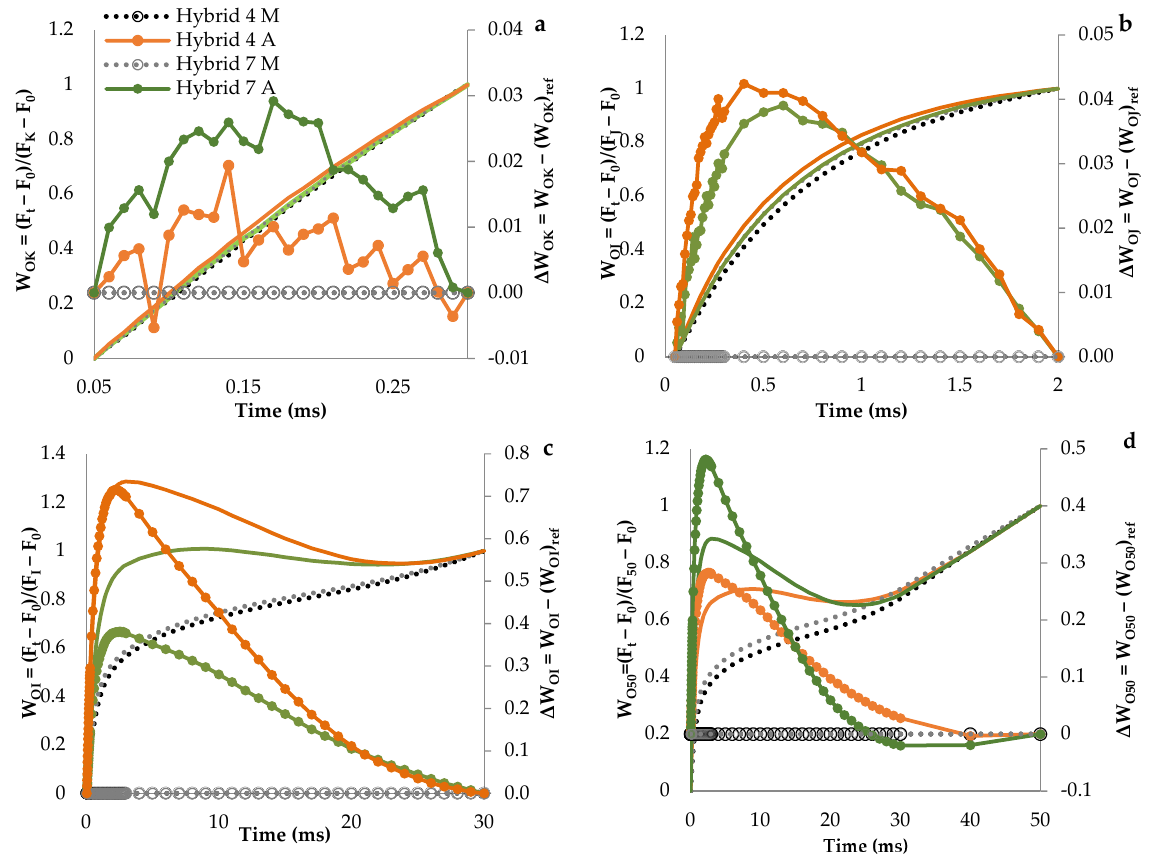
Figure 2. Chlorophyll a fluorescence transient curves in sunflower hybrids 4 and 7 under the morning (M) and afternoon (A) conditions. W OK = (F t − F 0 )/(F K − F 0 ) represents normalised transient data between steps O and K (L step); ( a ) plotted as difference kinetics ( Δ W OK = W OK − (W OK ) ref ) in the 0.05– 0.3 ms time range. W OJ = (F t − F 0 )/(F J − F 0 ) represents normalised transient data between steps O and J (K step); ( b ) plotted as difference kinetics ( Δ W OJ = W OJ − (W OJ ) ref ) in the 0.05–2 ms time range. W OI = (F t − F 0 )/(F I − F 0 ) represents normalised transient data between steps O and I (J step); ( c ) plotted as difference kinetics ( Δ W OI = W OI − (W OI ) ref ) in the 0.05–30 ms time range. W O50 = (F t − F 0 )/(F 50 − F 0 ) represents normalised transient data between steps O and 50 (I step); ( d ) plotted as difference kinet- ics ( Δ W O50 = W O50 − (W O50 ) ref ) in the 0.05–50 ms time range. Each curve represents the average kinetics of 12 replicates. Measurements in morning conditions were used as reference values of (W OK ) ref , (W OJ ) ref , (W OI ) ref , and (W O50 ) ref . Curve lines with marker points show W OK , W OJ , W OI , and W O50 (pri- mary axis), and curve lines without marker points show Δ W OK , Δ W OJ , Δ W OI , and Δ W O50 (secondary axis).